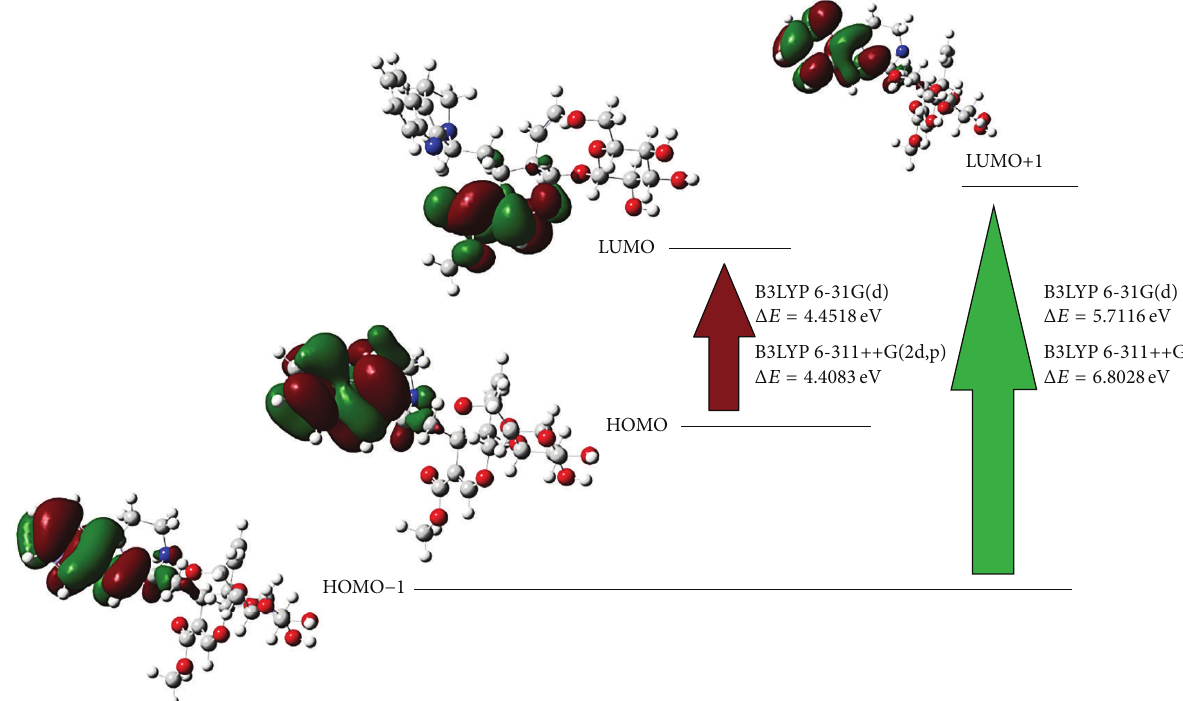
Figure 4: Frontier molecular orbitals of strictosidine.